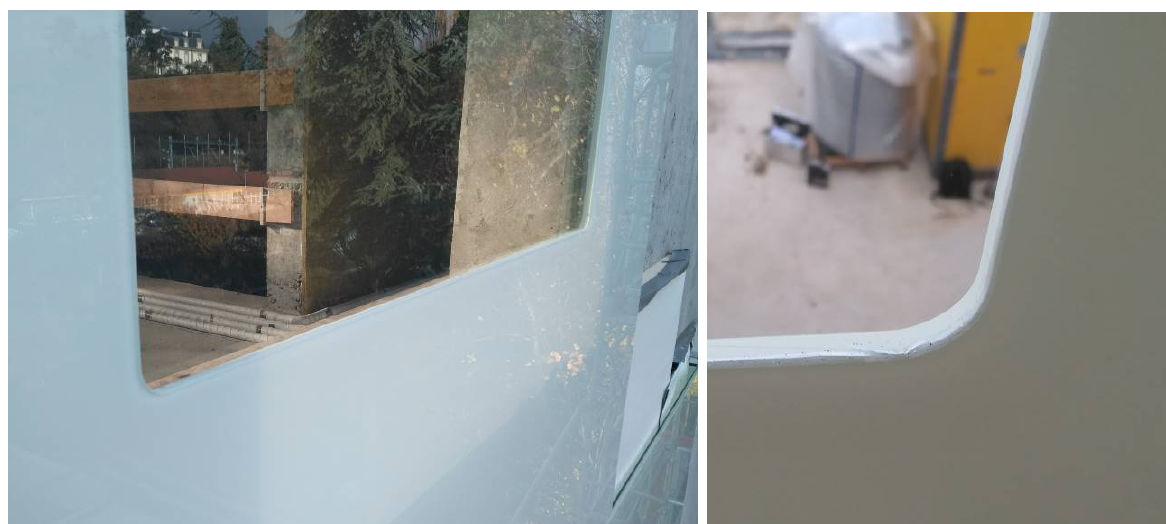
Fig. 11: Detail of pocket edge and PVB cut off quality for double skin